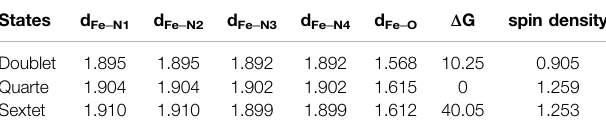
TABLE 1 | Selected Bond Lengths (Å), Mulliken spin density of Fe, and relative energies ( Δ G, kcal · mol − 1 ) of Fe(IV)-Oxo-Cz, in doublet, quartet and sextet states.